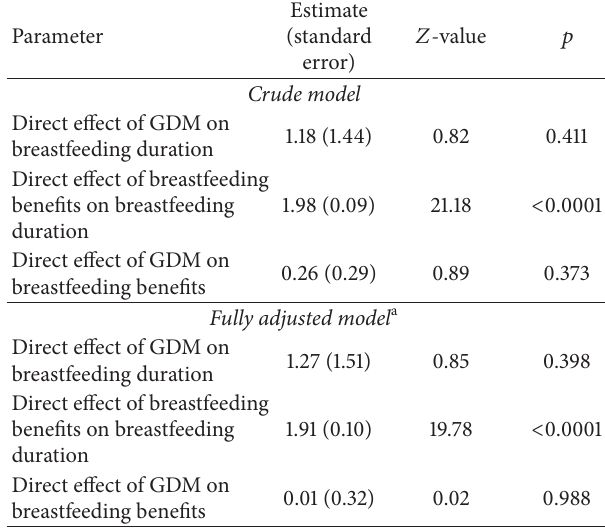
Table 2: Parameter estimates of the indirect effect of GDM on breastfeeding duration through perceived benefits of breastfeeding.